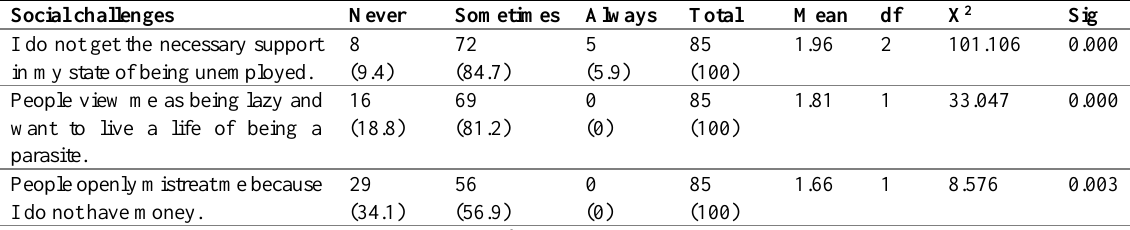
Table 4: Social challenges faced by the unemployed